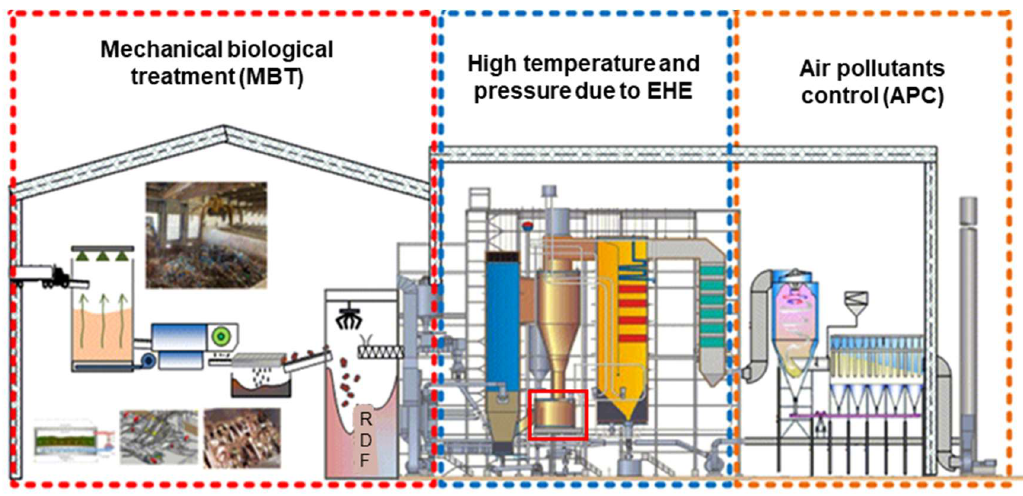
Figure 3. The technological process of advanced CFB incineration system.